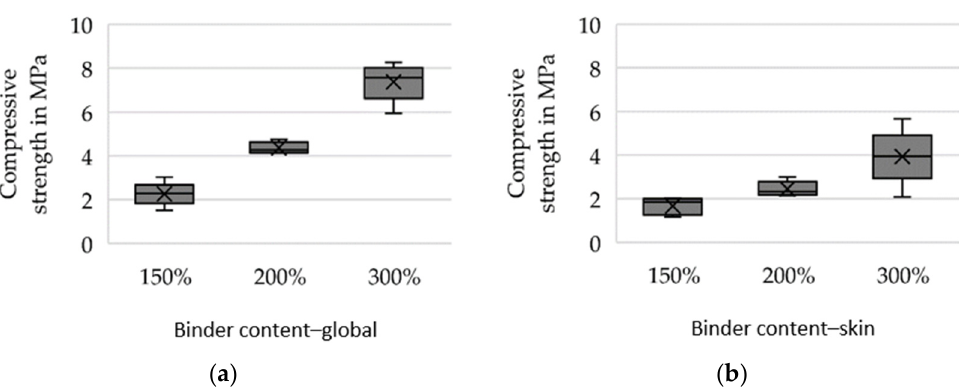
Figure 9. Compressive strength of specimens produced at varying binder contents. The binder content was increased ( a ) globally and ( b ) only in an outer skin of 5 mm.